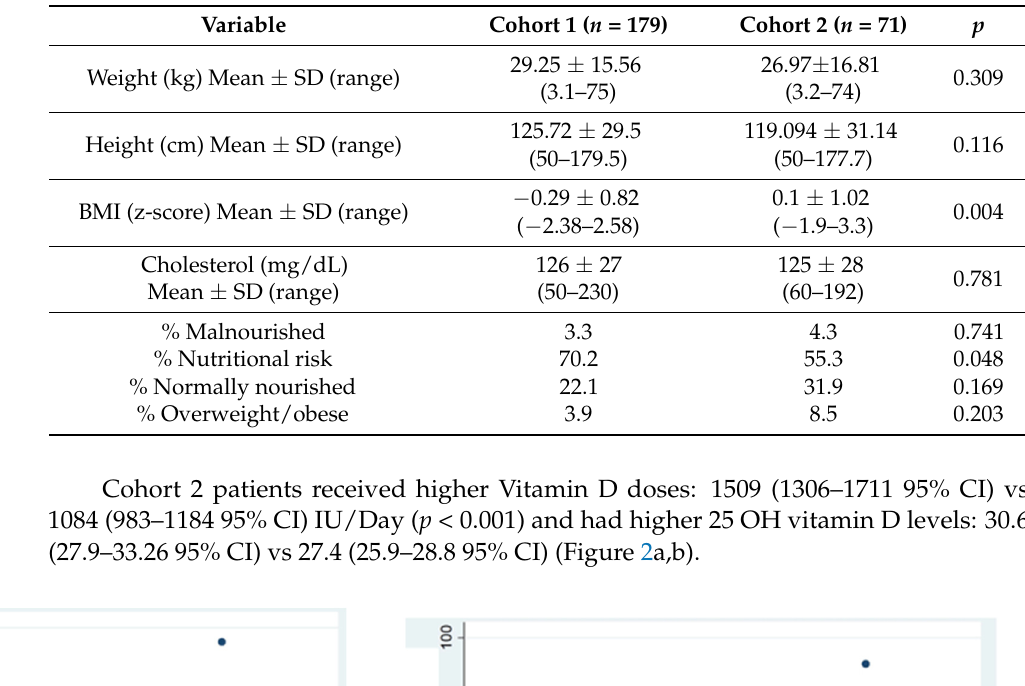
Table 3. Nutritional status of both cohorts.